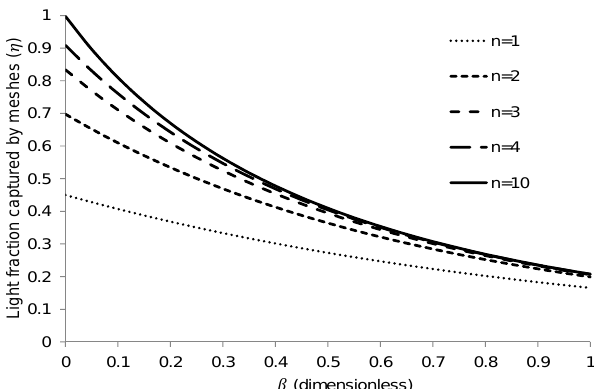
Figure 12. The fraction of captured light by the coated meshes ( r = 0.45) as a function of the dimensionless β parameter in a light absorbing